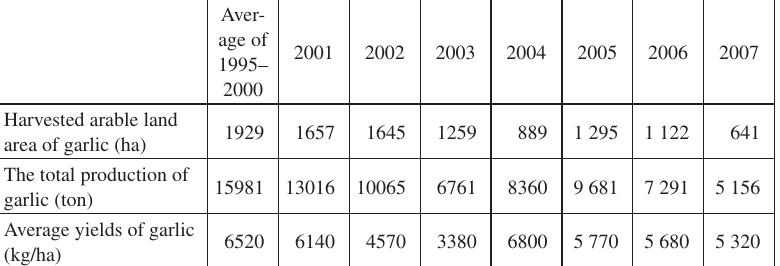
Table 2. Data of garlic cultivated in Hungary onto all of the economies projected (Gombkötô and Iváncsics, 2009b)